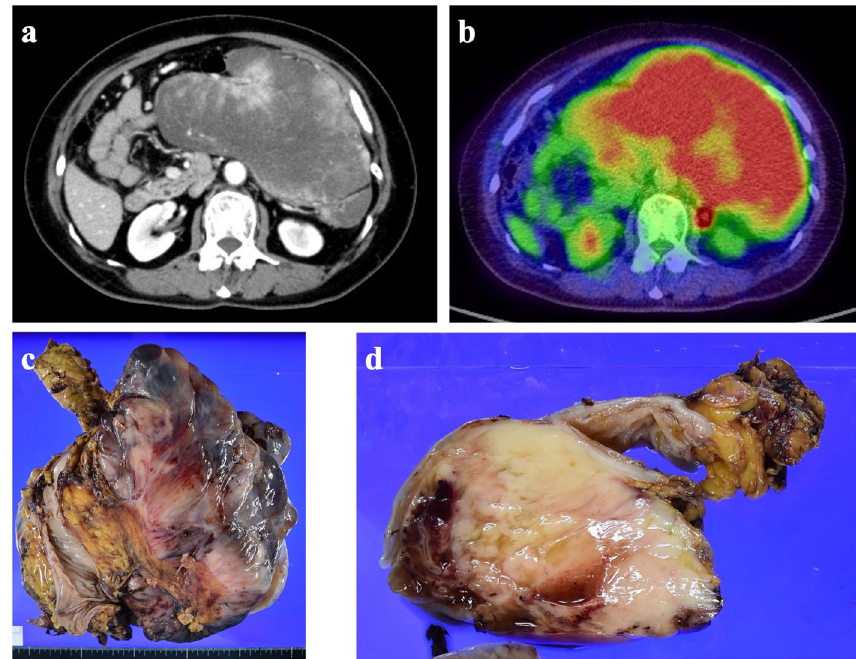
Fig. 1 a Contrast-enhanced CT findings revealed a large submucosal mass approximately 180 mm in length, contiguous with the transverse to descending colon. Heterogeneous contrast images were visible within the mass. b PET-CT demonstrated FDG accumulation (SUVmax: 9.42) within the mass, with no evidence of obvious abnormal accumulation elsewhere. c The resected intra-abdominal tumor was 260 and weighed approximately 3.5 kg. d The cut surface of the mass was grayish-white, with a circumscribed surface, and an extramural growth from the transverse colon. Mucinous degeneration was observed in certain areas along with a certain degree of bleeding